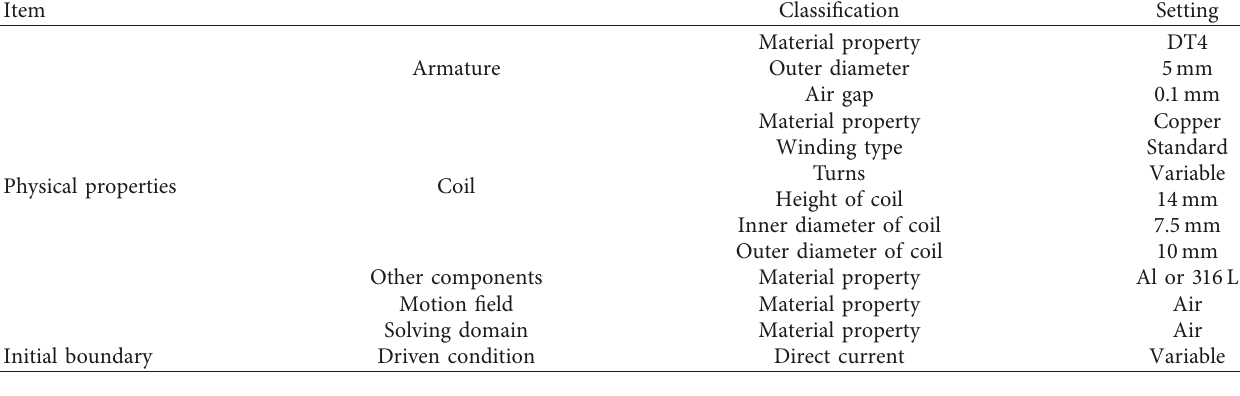
Table 1: Detailed information of Maxwell computation.